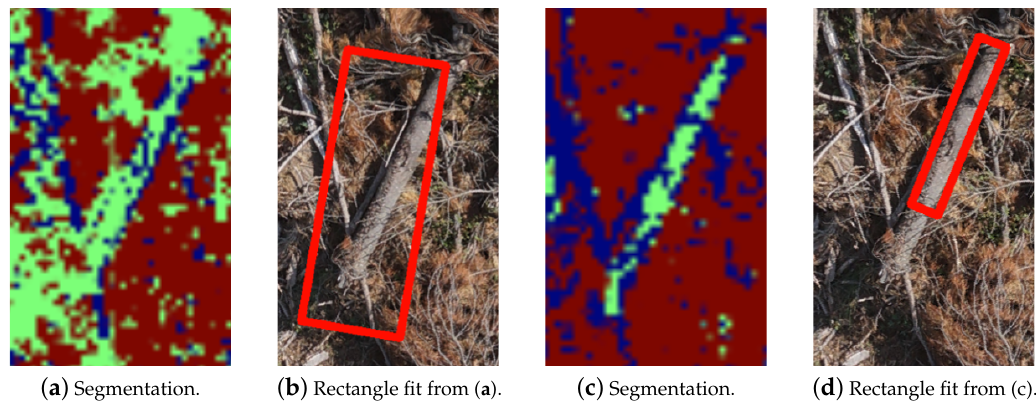
Figure 15. An example of the dependence of the rectangle fit on the segmentation performance, with results from two different cross-validation folds from plot 6 (i.e., the segmentation models were different). The segmentation in ( a ) produces the rectangle in ( b ), and the segmentation in ( c ) produces the rectangle in ( d